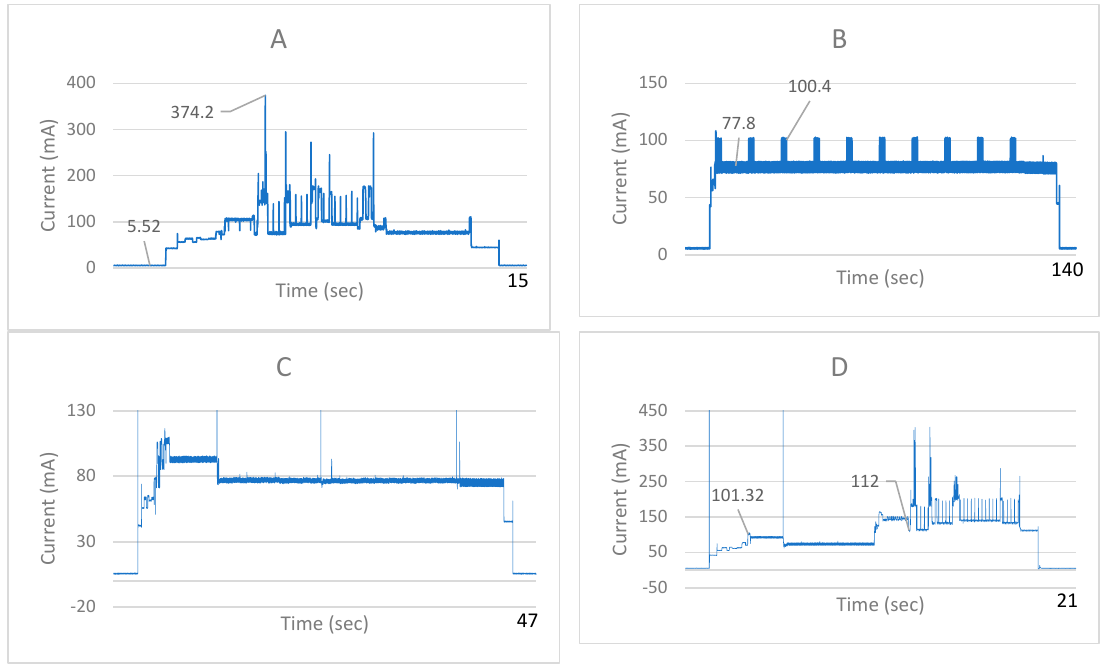
Figure 3. Current measurements with INA219 (battery was at ~3.64 V) as described in Section 2.4.1. ( A ) Medication schedule update, ( B ) sound notifications at the pill intake time, ( C ) LED notifications indicating the appropriate pills for intake, and ( D ) acquisition of food or supplement photo and upload to the server for interaction